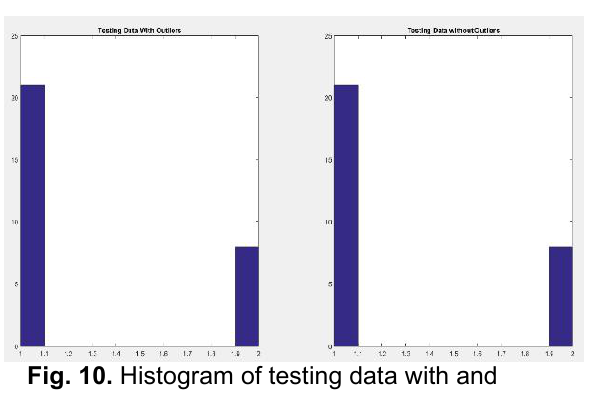
Fig. 9. Histogram of training data with and without outliers